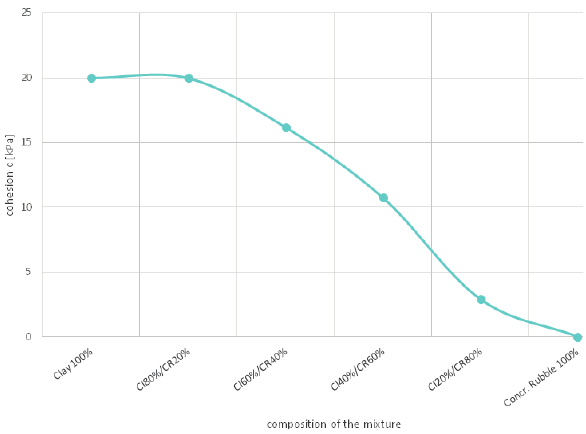
Figure 8: Change in the cohesion c , depending on the composition of the mixture.